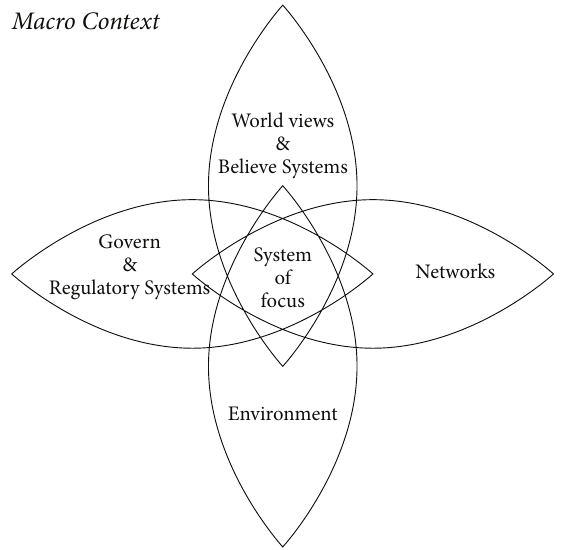
Figure 2. The EIMS basic